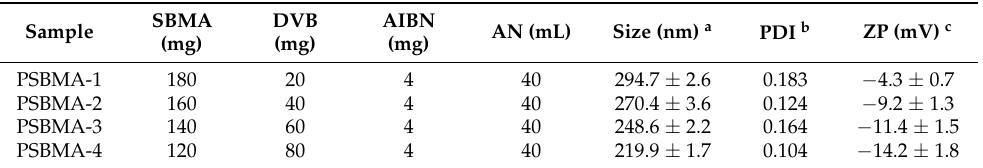
Table 1. Colloidal properties for the series of PSBMA nanogels with different monomer/crosslinker feeding